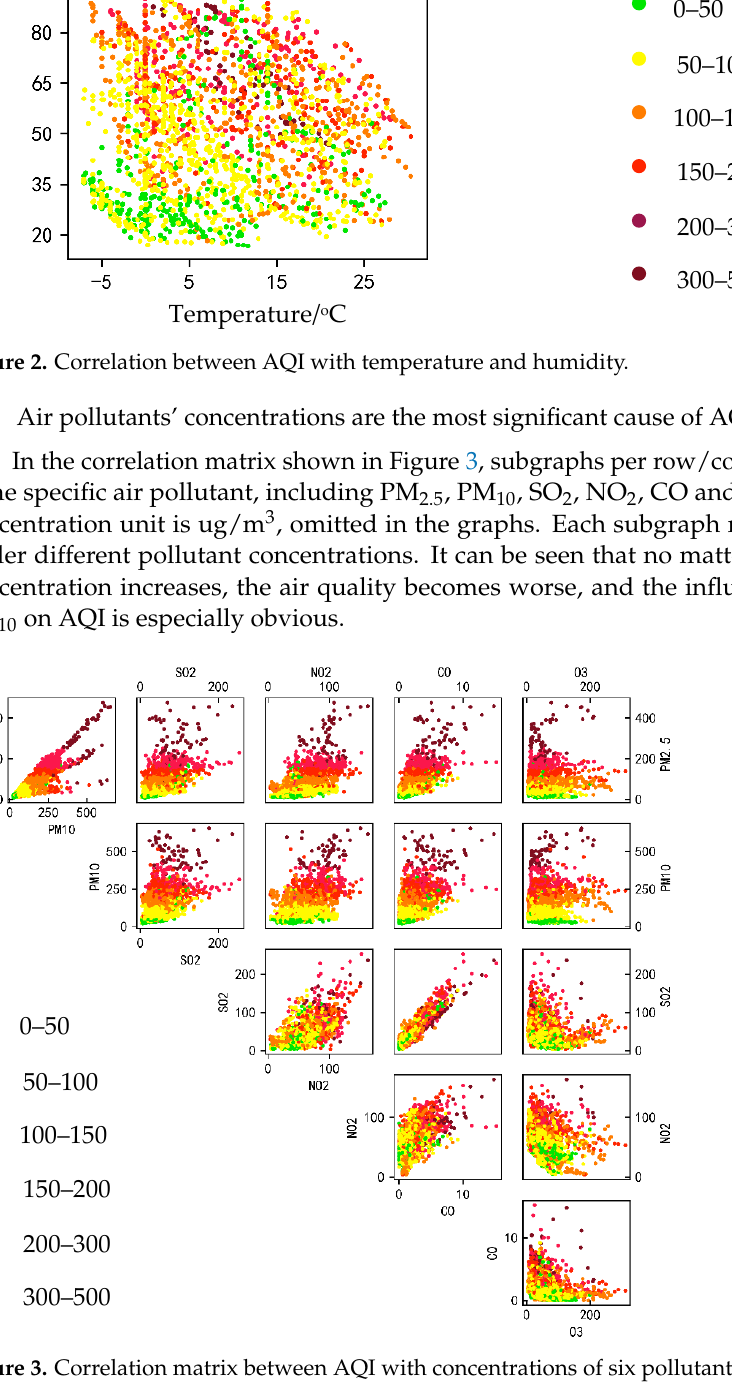
Figure 4. Daily variation in AQI at different source type monitoring stations. 2.3. Method and Principles 2.3.1. DNN DNN is a network model suitable for dealing with complex nonlinear relationships and has excellent regression performance. As shown in Figure 5, the DNN model is a hi- erarchical architecture. Each arrow in the network has its linear coefficient w and bias b . In fact, the local model, such as the perceptron, is composed of a linear relationship and an activation function σ(·). To represent the operation with matrices, the linear coefficient from the k- th neuron of layer l to the j -th neuron of layer l + 1 is defined as